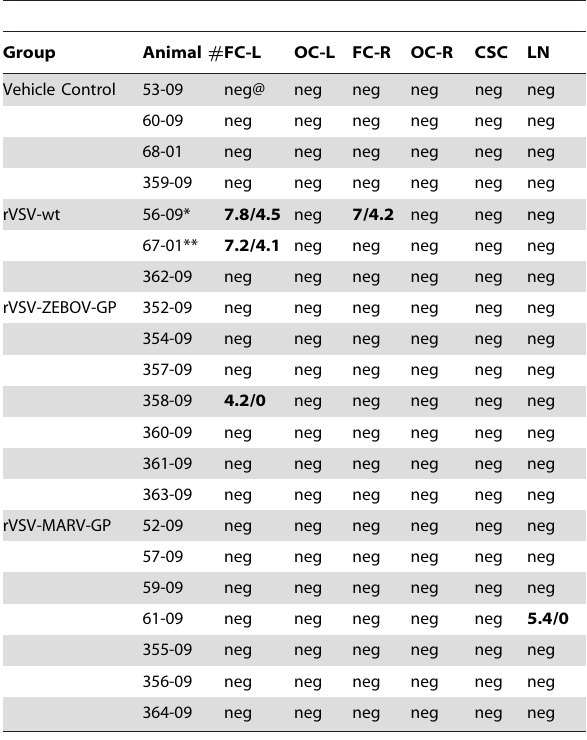
Table 2. Viral loads in neural tissue and LN as measured by qRT-PCR (log10 copies/g)/or virus log10.